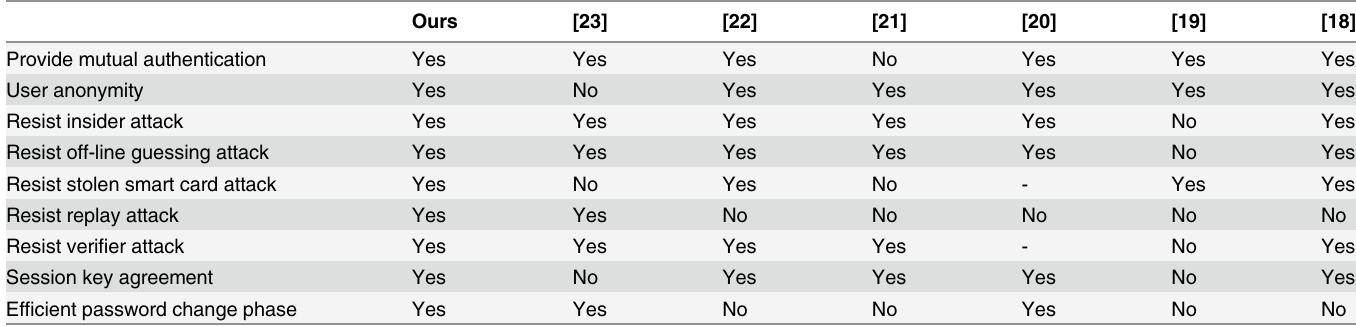
Table 5. Functionality comparison.